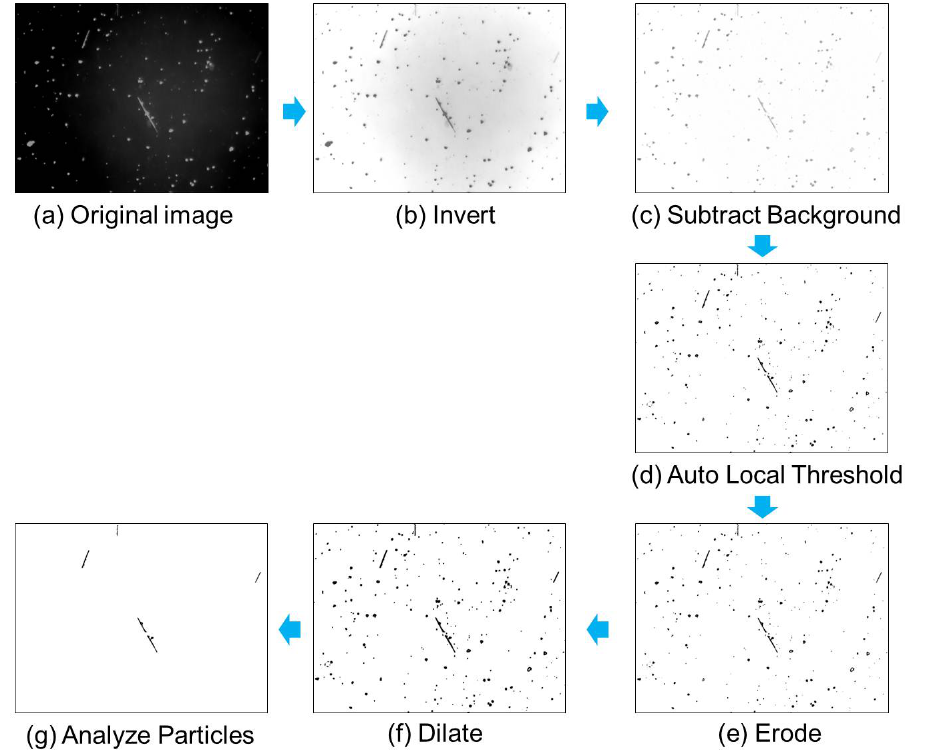
Figure 2. Asbestos sample images undergone specific steps for image processing and analysis in HTM method (a) Original image of amosite; (b) Invert; (c) Subtract Background (rolling = 10); (d) Auto Local Threshold (radius = 5); (e) Erode; (f) Dilate; (g) Analyze Particles (circularity = 0 − 0.33, size =